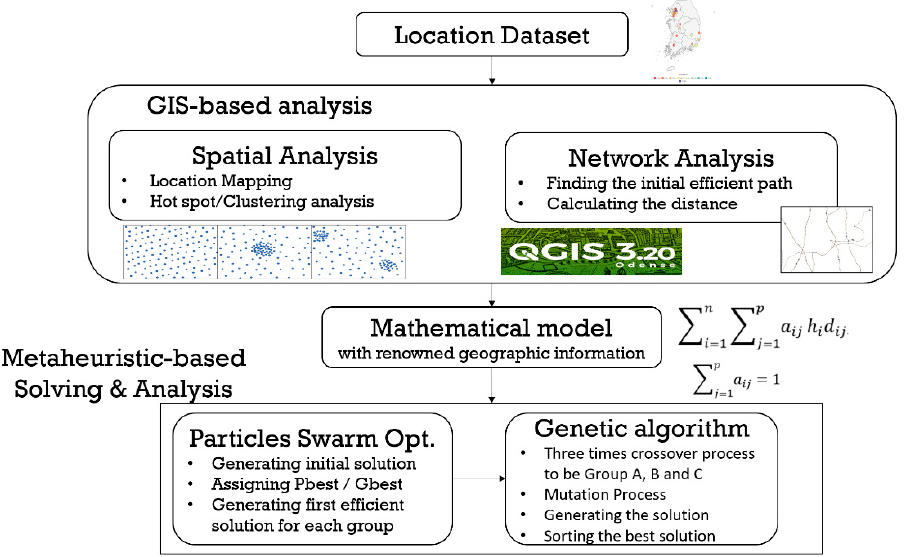
Figure 1. The schema for the proposed method.